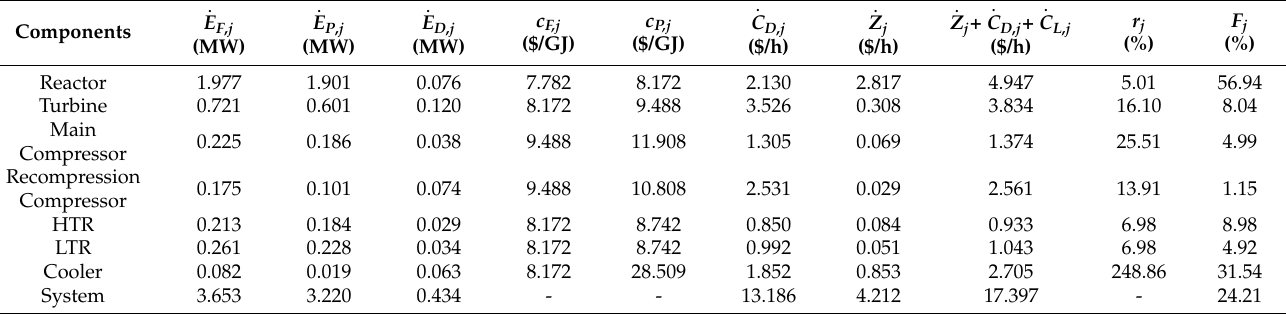
Table 5. Exergy and exergoeconomic results for a basic parameters